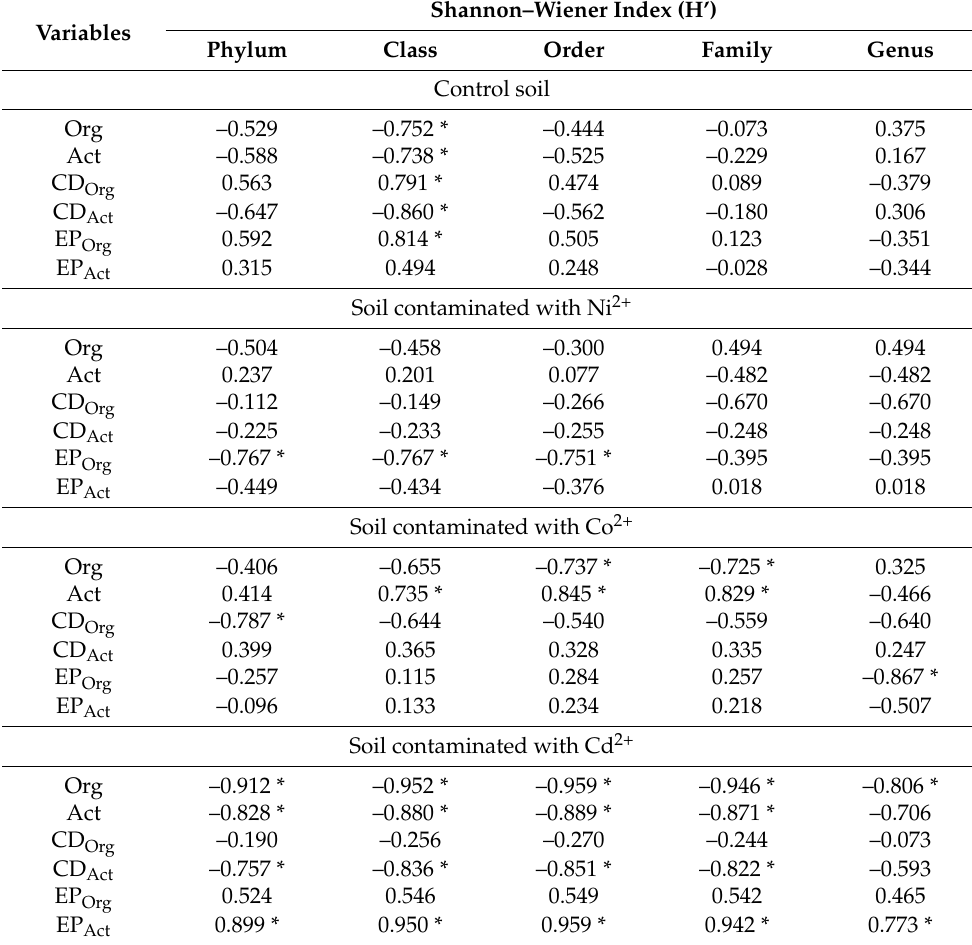
Table 3. Coefficient of correlation between bacterial count, colony development and ecophysiological diversity index, and the value of the Shannon–Wiener index (H’) calculated for individual taxa, regardless of test plant